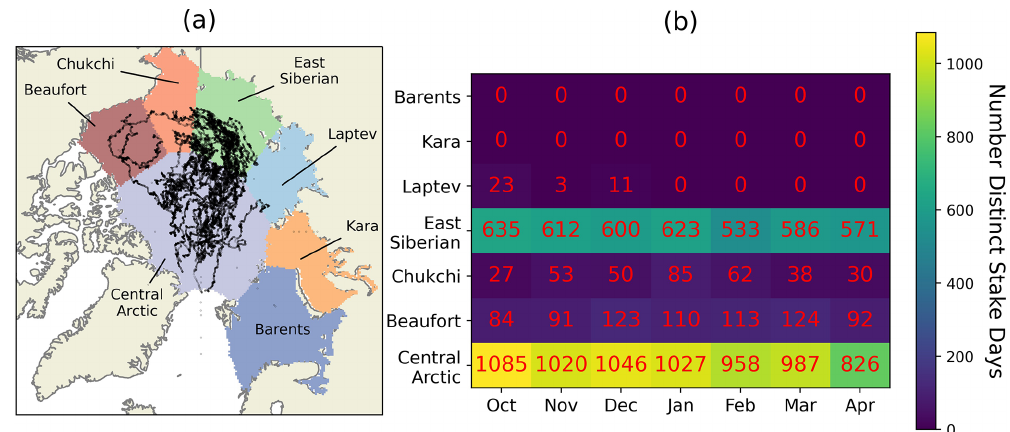
Figure 2. (a) Tracks of Soviet drifting stations 3–31. (b) Number of days in each region in each month that snow stake measurements were